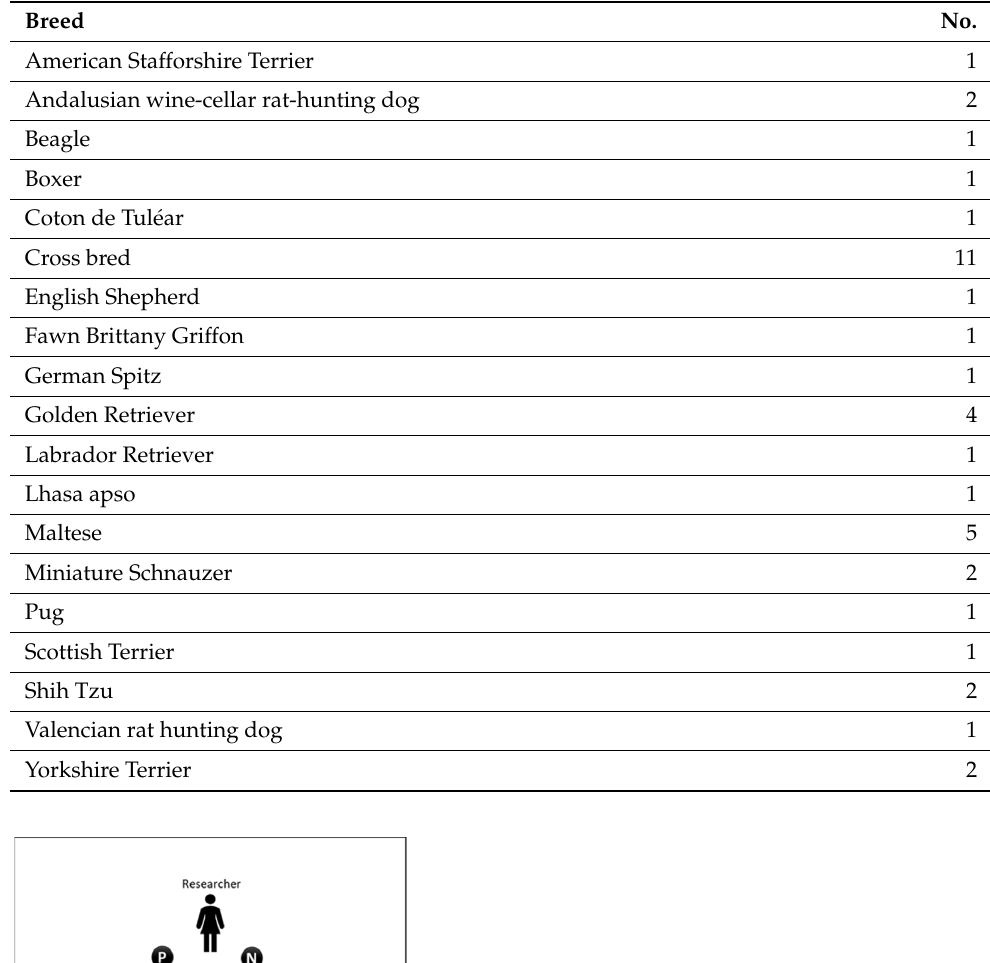
Table 3. Breeds of dogs that participated in the Study 2.